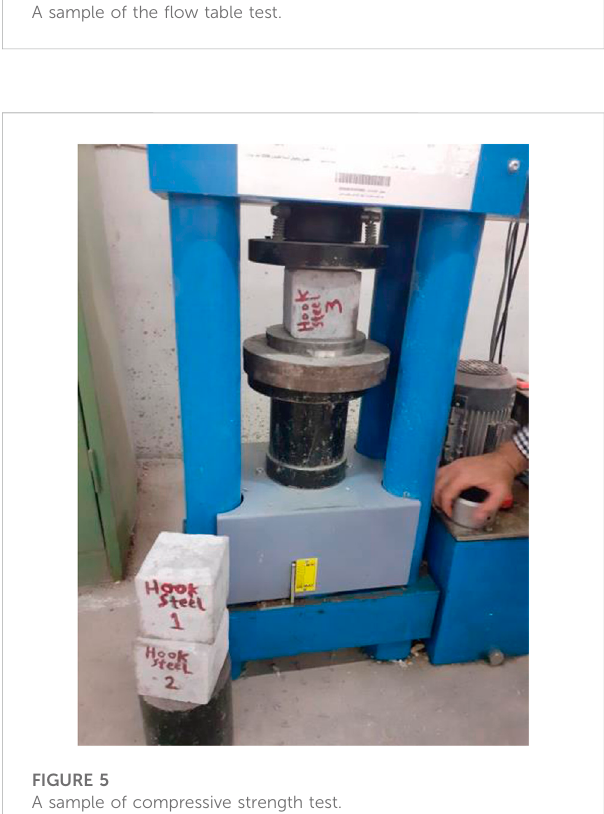
A sample of compressive strength test.